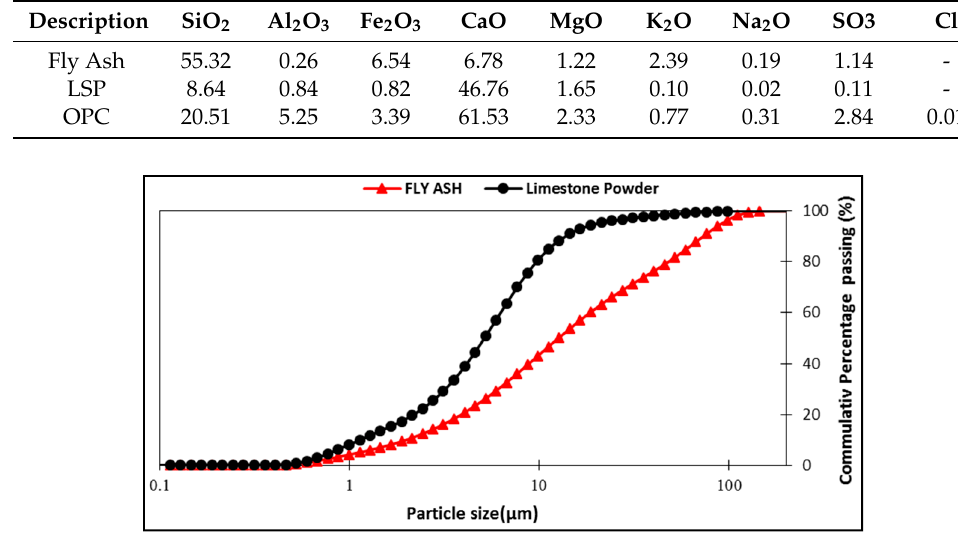
Figure 2. Particle size distribution of LSP and FA.